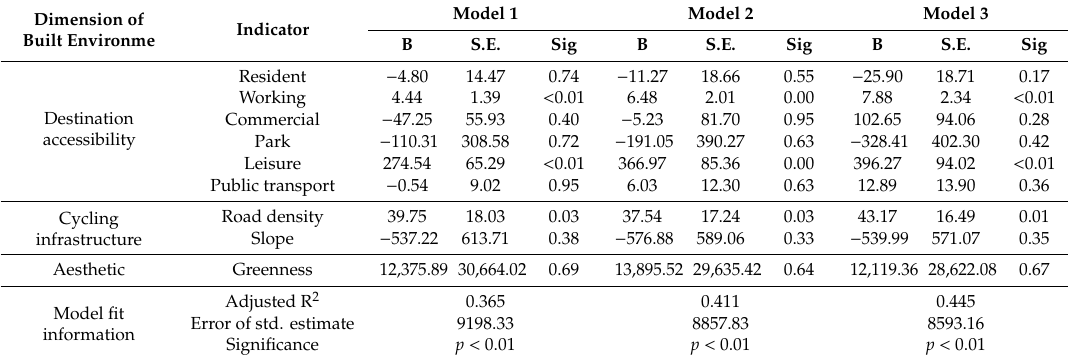
Table 3. Results of Regression